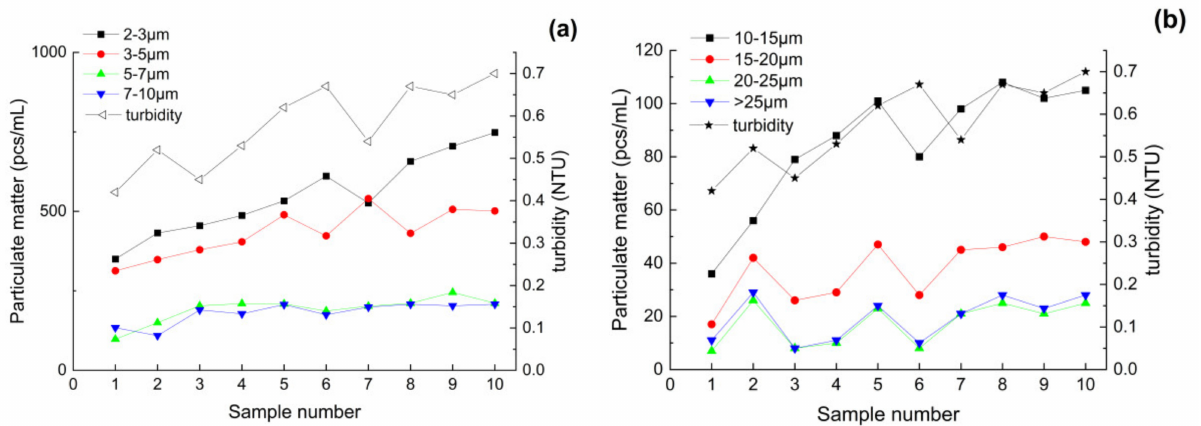
Figure 2. Changes in the number of particulate matter and turbidity for along the pipeline: particle size 2~10 µ m ( a ); Particle size >10 µ m ( b